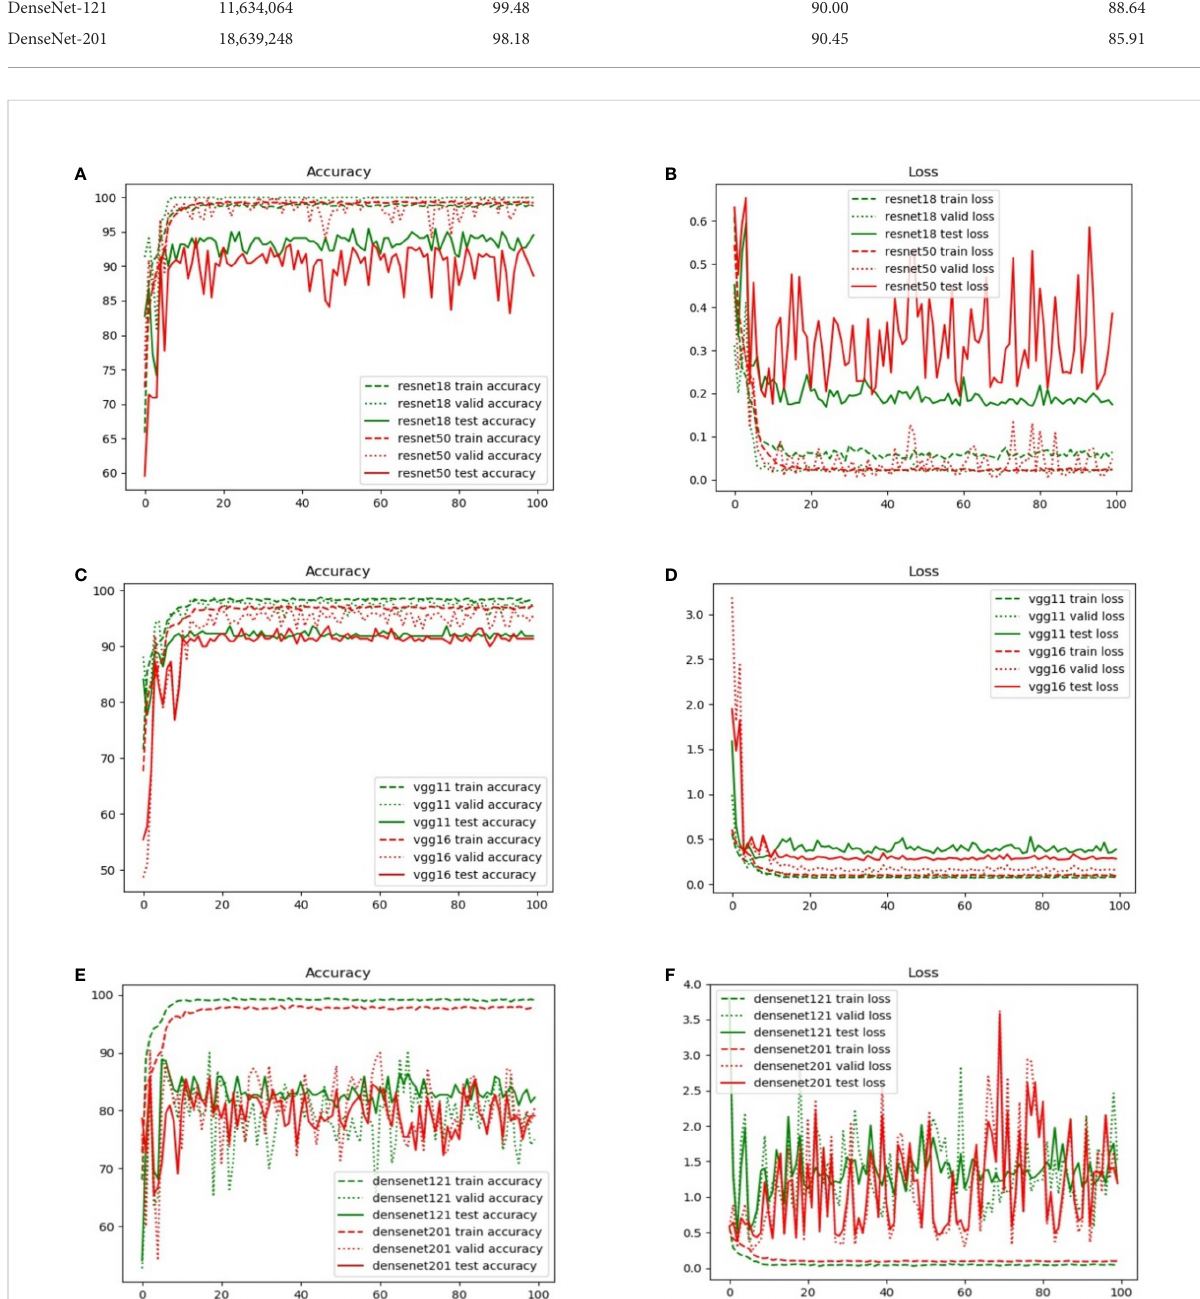
FIGURE 5 Comparison of the training, validation, and test set accuracy and loss curves with various backbone models: (A) ResNet-18, (B) ResNet-50, (C) VGG-11, (D) VGG-16, (E) DenseNet-121, and (F)